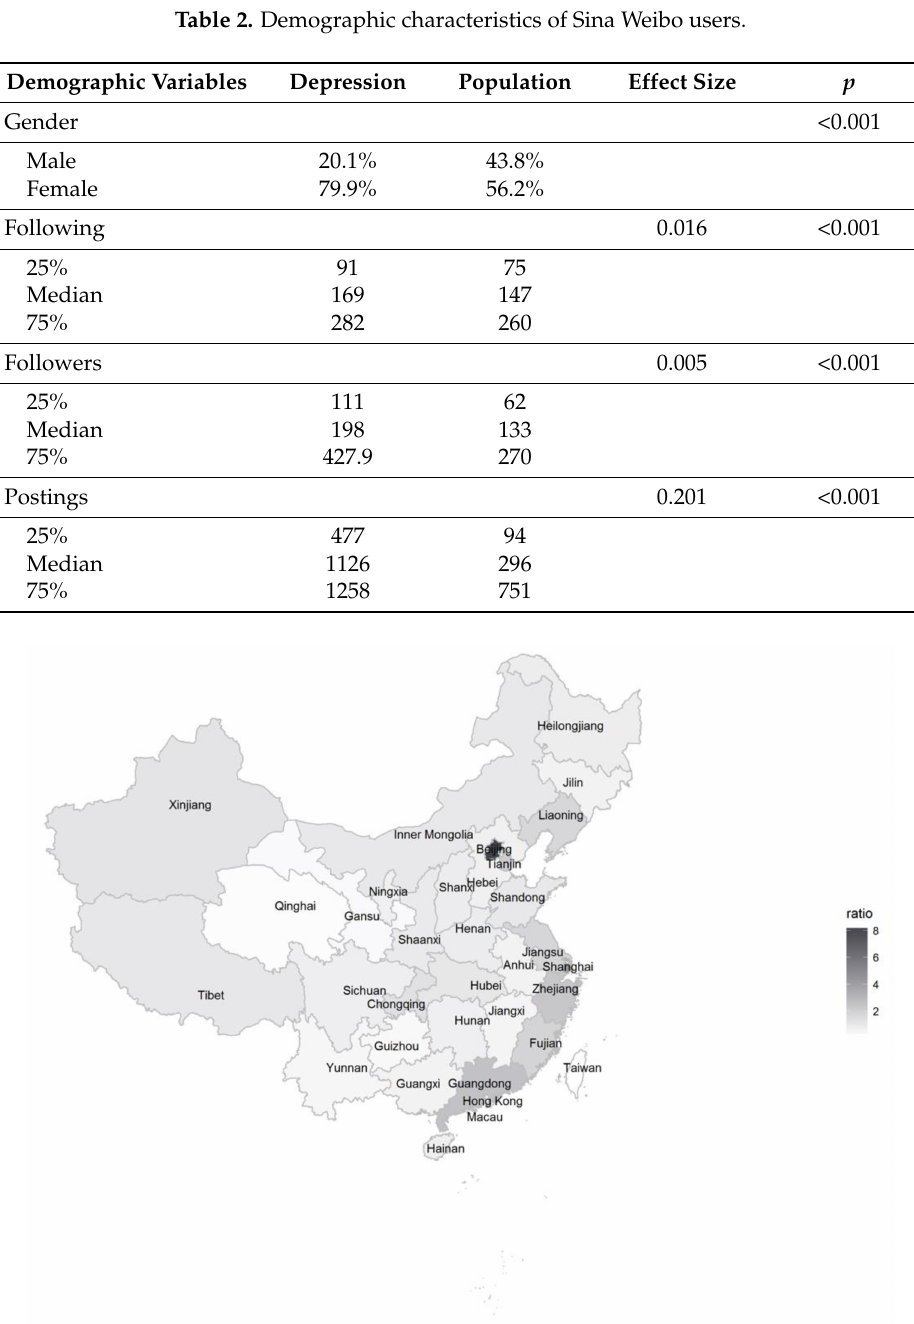
Figure 2. Geographic distribution of users with